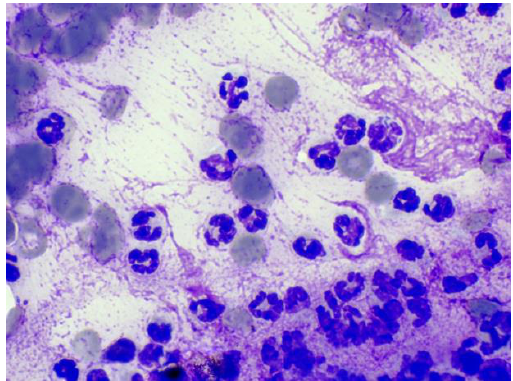
Figure 4. Degenerate neutrophils with intracellular bacilli consistent with suppurative septic discospondylitis (case 2). Modified-wright stain, 100×.